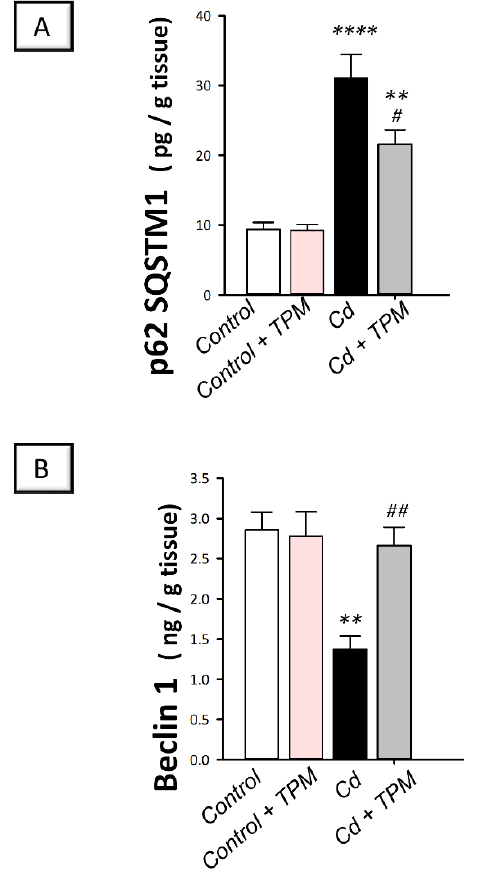
Figure 7. Effect of cadmium and/or topiramate on autophagy markers in testes of rats. The co-treat- ment with topiramate activated testicular autophagy that was inhibited by cadmium administra- tion. This was manifested by the lowered accumulation of the negative autophagy marker p62 SQSTM1 [H (3, 20) = 25.42, p < 0.0001] ( A ) and upregulated protein expression of the positive au- tophagy marker Beclin 1 [H (3, 20) = 8.80, p = 0.0006] ( B ). Results are demonstrated as the mean ± standard error of the mean (SEM) for six rats in each experimental group. ** p < 0.01, **** p < 0.0001 signifies statistical significance versus the control group; # p < 0.05, ## p < 0.01 signifies statistical significance versus cadmium chloride-treated group. p62 SQSTM1, sequestome 1 protein 62. TPM, topiramate; Cd, cadmium chloride.